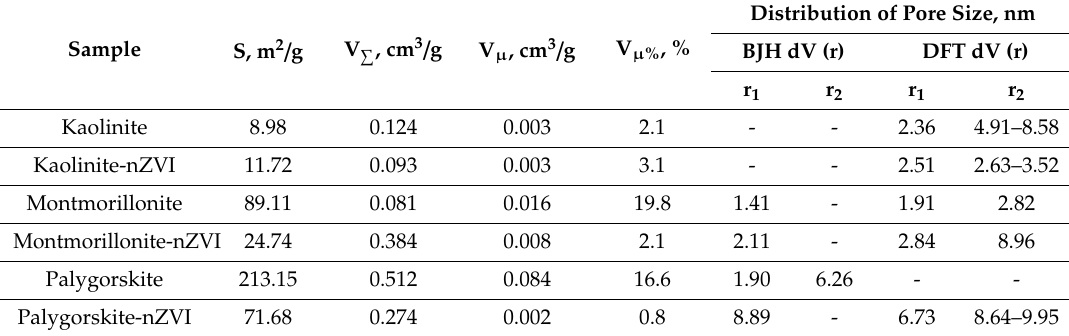
Table 1. Characteristics of the porous structure of the samples.